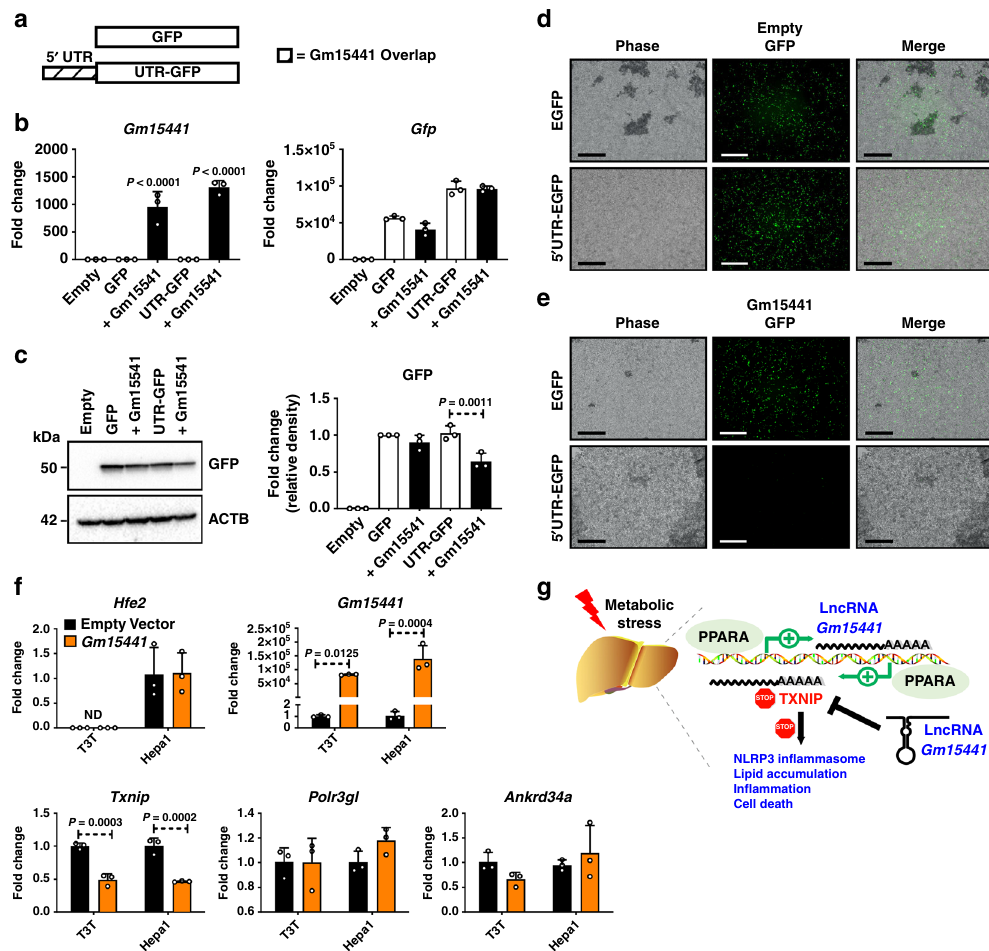
Fig. 7 Gm15441 regulates TXNIP translation in part through IRES sequences found within the 5 ′ UTR of TXNIP. a Schematic representation of GFP construct inserts with or without the TXNIP 5 ′ UTR sequence. b Analysis of Gm15441 RNA and Gfp mRNA in Hepa-1 cells. c Western blot analysis of GFP protein and relative density of GFP signal from Hepa-1 cells (right). d Fluorescence of GFP in Hepa-1 cells transfected with GFP with empty or Gm15441 plasmid DNA for 48 h ( n = 3). Scale bars represent 20 nm (100x). e Fluorescence of GFP in Hepa-1 cells transfected with 5 ′ UTR sequence containing GFP with empty or Gm15441 plasmid DNA for 48 h ( n = 3). Scale bars represent 20 nm (100x). f Analysis of Hfe2 , Pol3gl , and Ankrd34a mRNAs from Hepa-1 and NIHT3T cells transfected with empty plasmid or Gm15441 expression vector for 24 h. Each data point represents mean ± SD for n = 3 replicates. Adjusted p values, provided in the panels, as determined by ANOVA with Tukey ’ s multiple comparison correction, one-sided for comparisons in